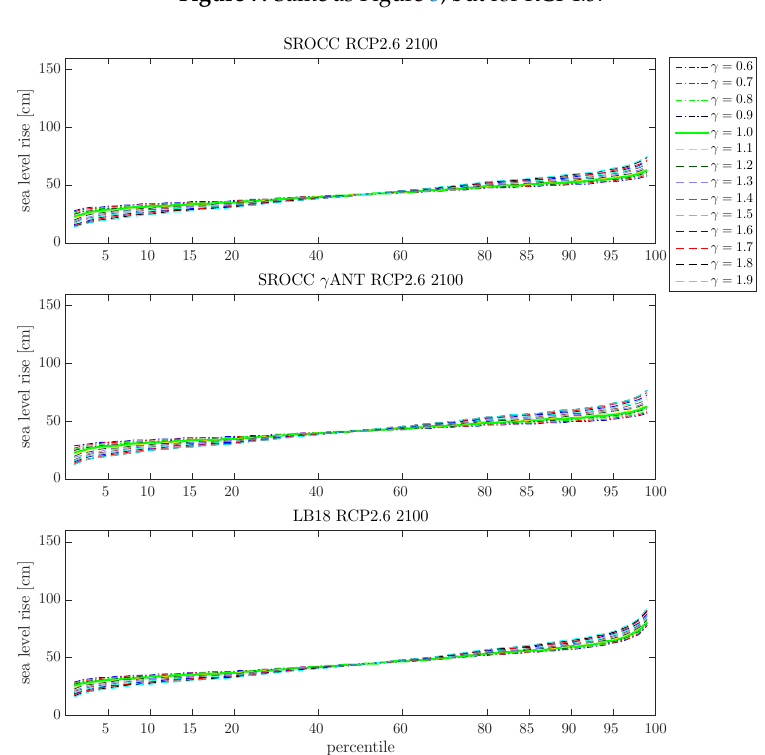
Figure 7. Same as Figure 5, but for RCP4.5.